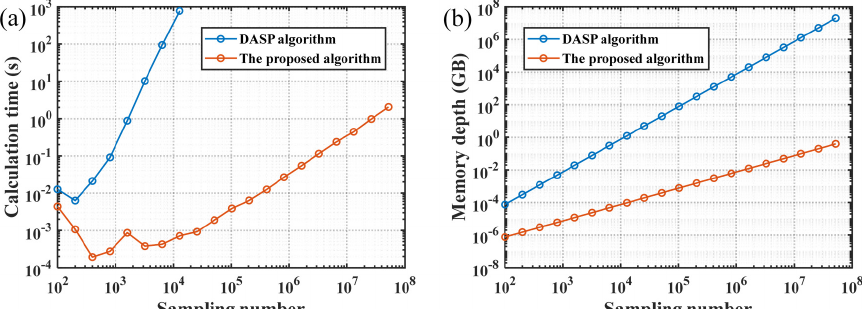
Figure 11. Comparison of the calculation time and the memory depth based on the proposed signal reconstruction algorithm and the DASP algorithm in [21]. ( a ) Calculation time under different sampling numbers. ( b ) Memory depth under different sampling